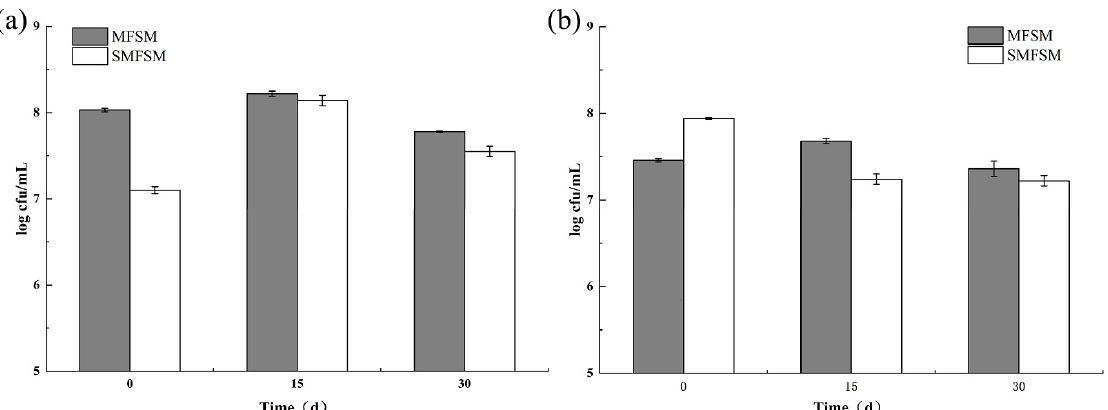
Figure 2. Effect of two mixed fermentation methods on the number of viable bacteria during storage: ( a ) the change in Streptococcus thermophilus during storage and ( b ) the change in Lactobacillus delbrueckii subsp. bulgaricus during storage .